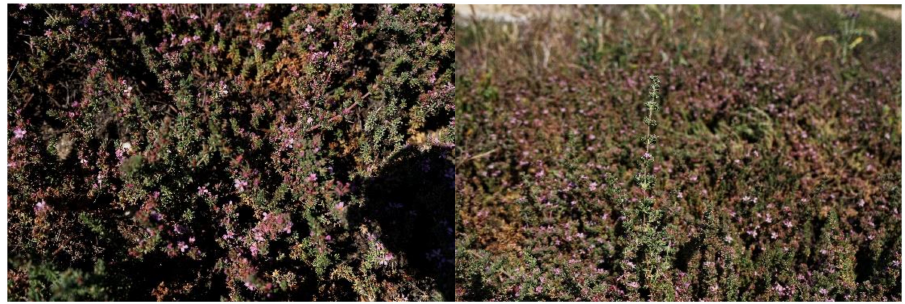
Figure 1. Frankenia laevis L. from Southern Algarve, Portugal. Photos by Chia-Yu